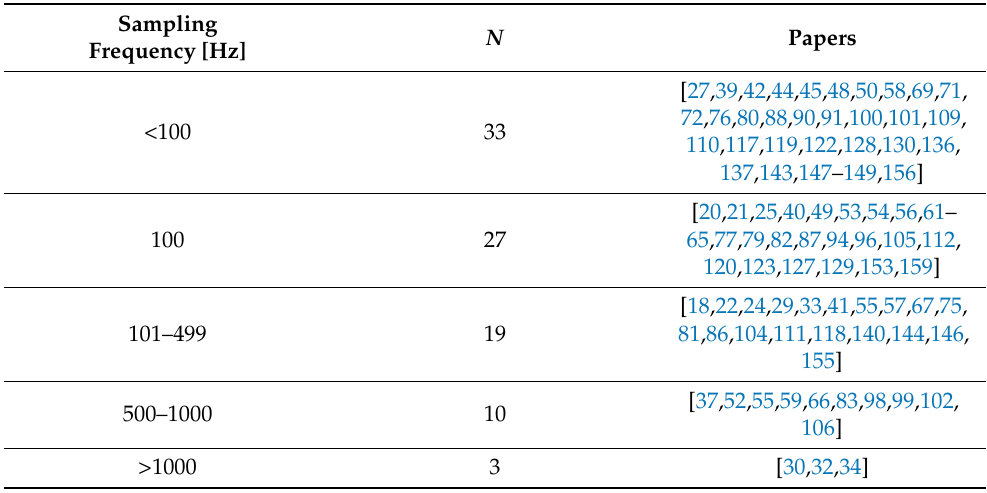
Table 3. Classification of sampling frequency of sensors and systems. Some studies are not included because this information is missing.